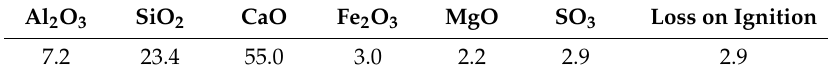
Table 3. Chemical compositions of Portland cement (%).